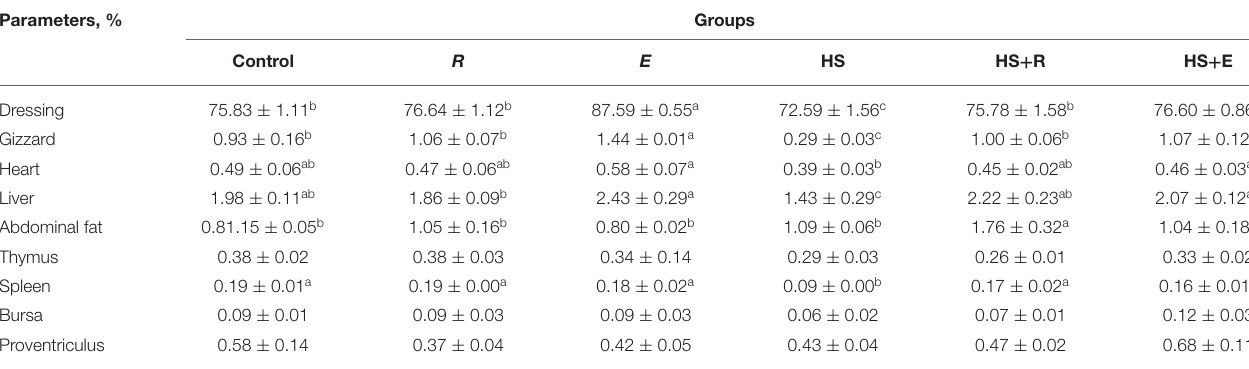
TABLE 4 | Effects of supplementation with digestive enzymes and/or Ruminococcus sp. on the results of the slaughter analysis of chickens (at day 42) and relative weights of selected organs as percentage of body weight. Parameters,